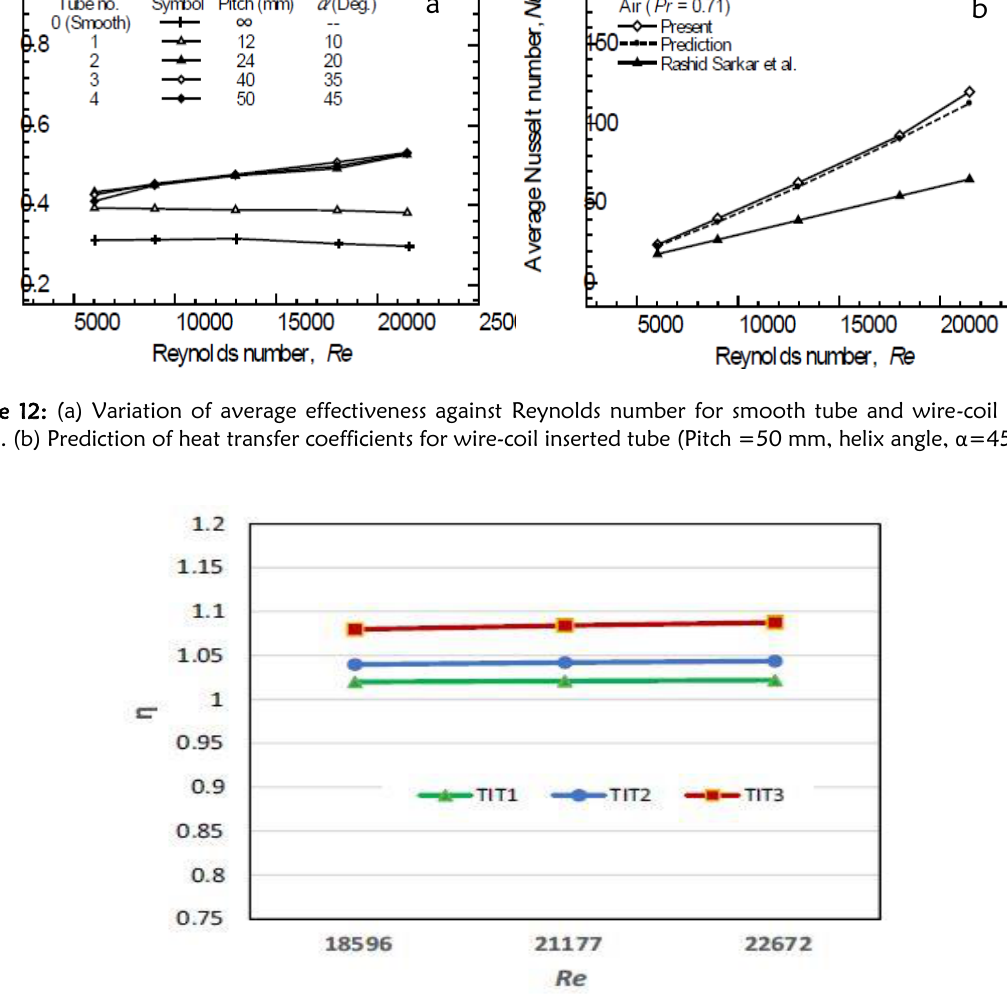
Figure 13: Thermal performance factor Vs Reynolds number for tube inserts [20].